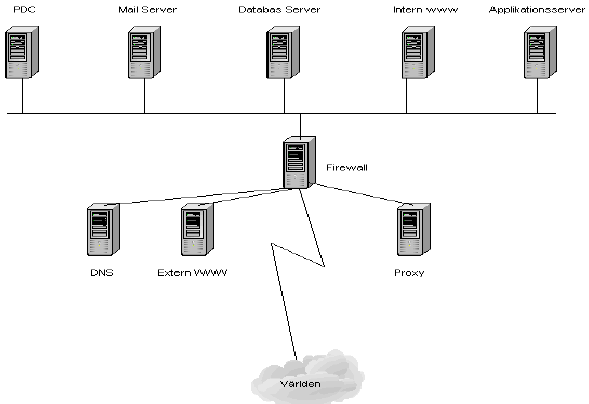
Figure 4. Project system